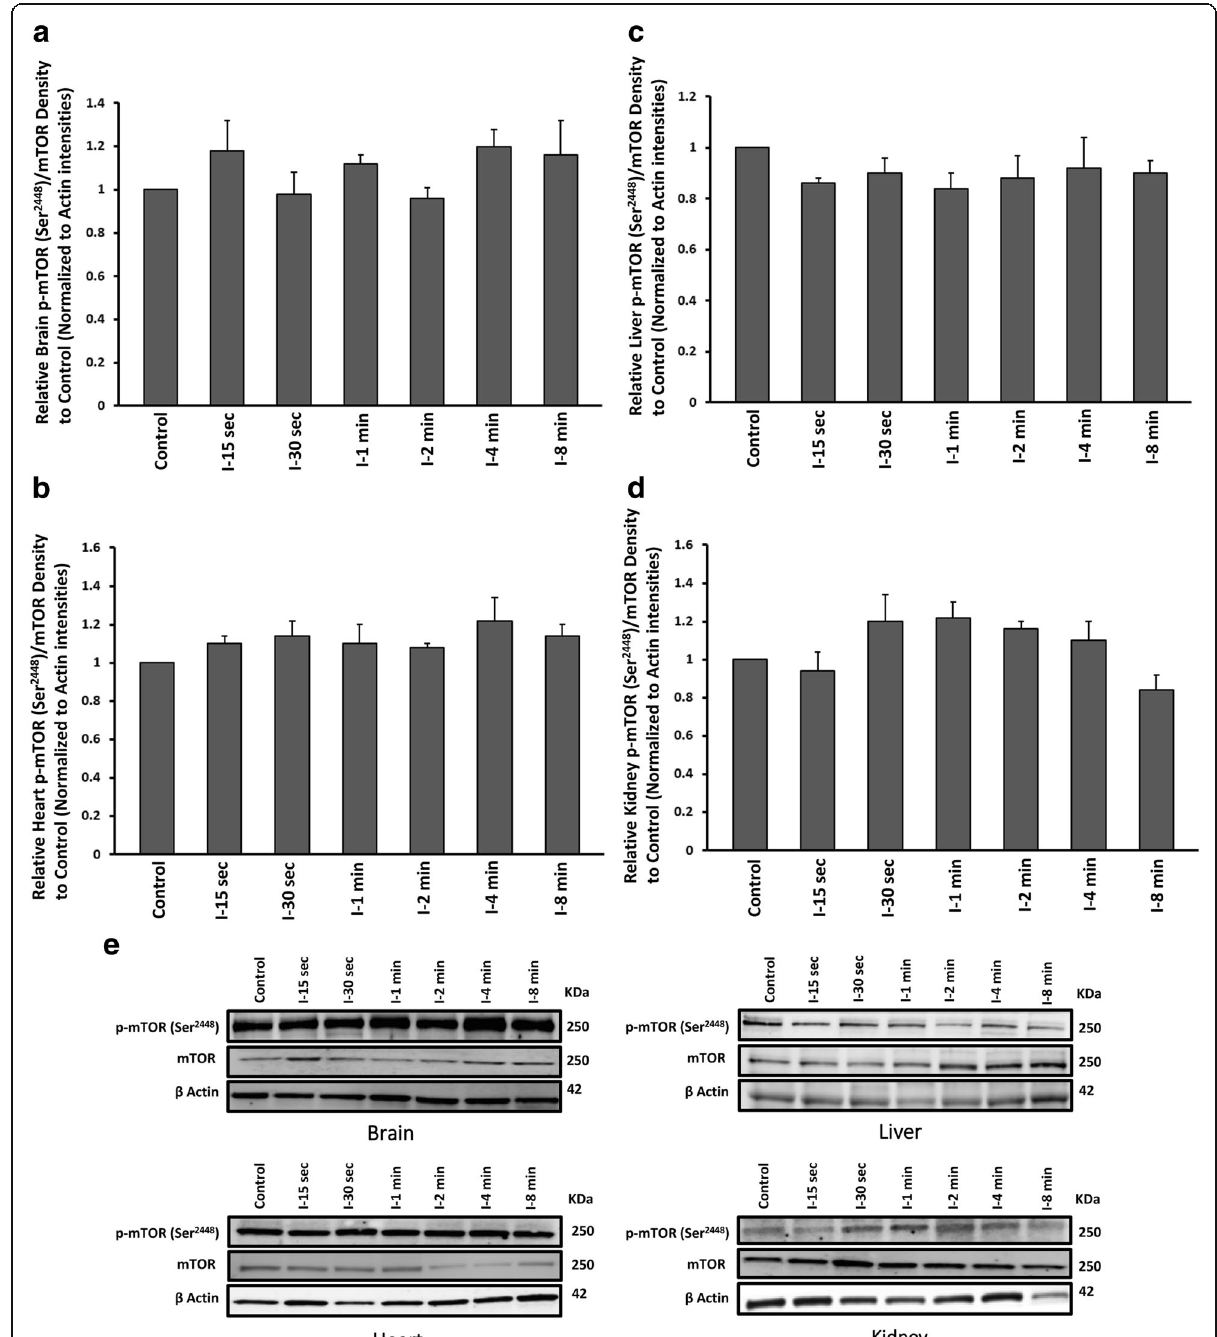
Fig. 5 Western blot analysis results of p-mTOR at Ser 2448 and total protein of mTOR assessment from a brain b heart c liver and d kidney tissues of ischaemic and control groups. All values are expressed as percent change relative to control group and were corrected by the Actin level. e Protein band intensities of p-mTOR (Ser 2448 ), mTOR and Actin. I-15 s: 15 s ischemia, I-30 s: 30 s ischemia, I-1 min: 1 min ischemia, I-2 min: 2 min ischemia, I-4 min: 4 min ischemia, I-8 min: 8 min ischemia * p < 0.001 all groups vs control (One Way ANOVA, followed by post hoc Tukey ’ s). Error bars depict the